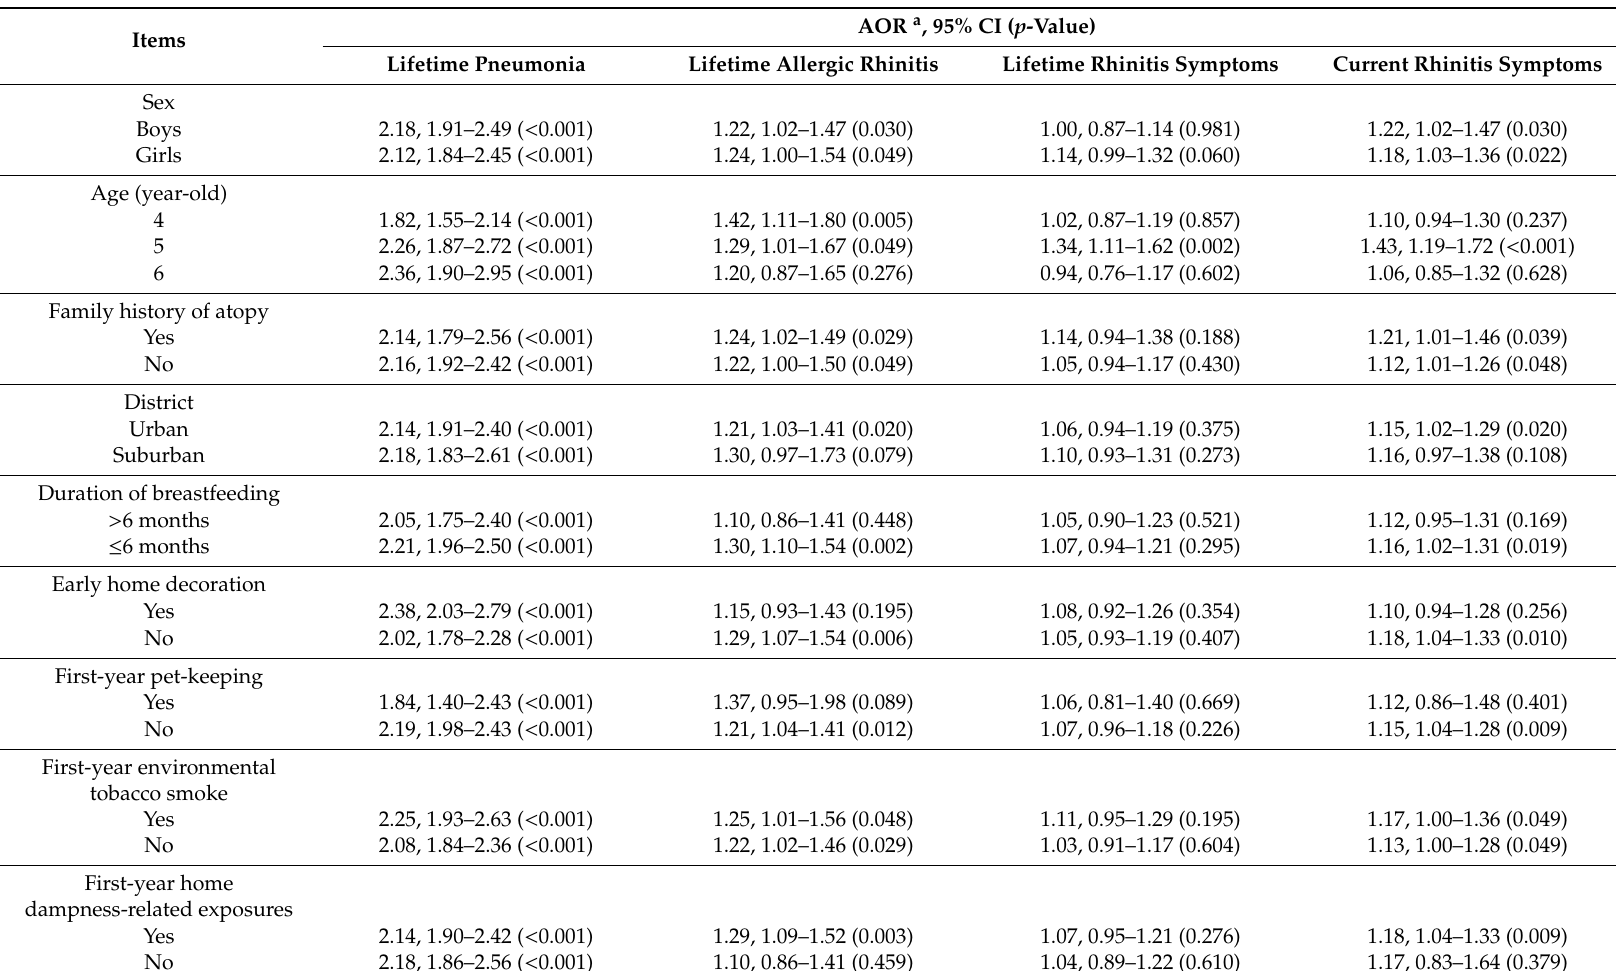
Table 7. Associations of first-year antibiotics exposure with pneumonia, allergic rhinitis, and rhinitis symptoms in